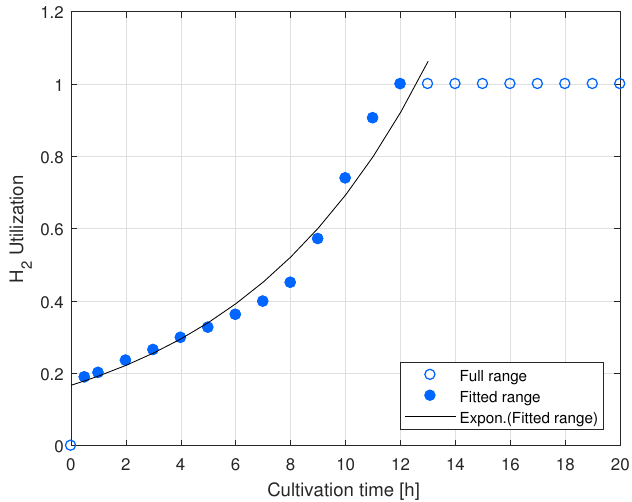
Figure A1. Development of hydrogen utilization in the small-scale BES. The exponential curve fitted to the part of the data range is associated with exponential biomass